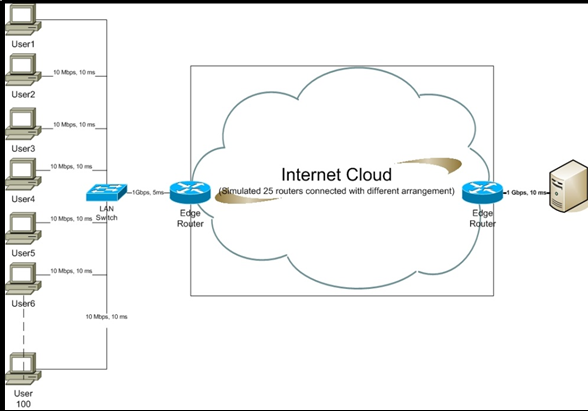
Figure 1: users connected to internet to send data to the server